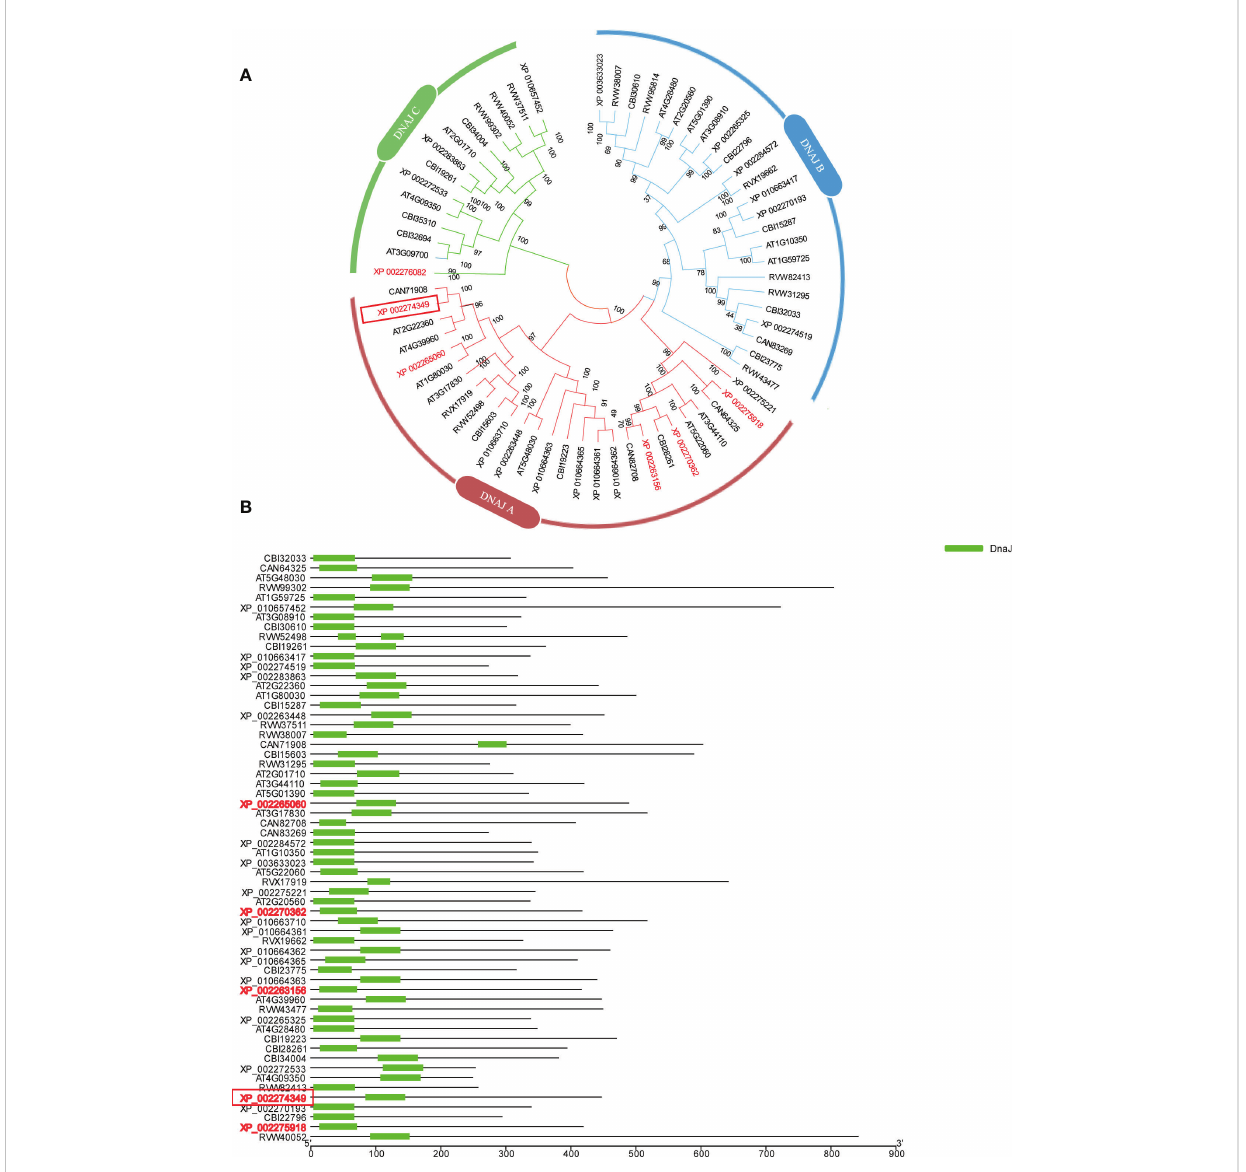
POD (Figure 7G) CAT (Figure 7H) and the osmotic substance proline (Figure 7I) to protect the plant during elevated